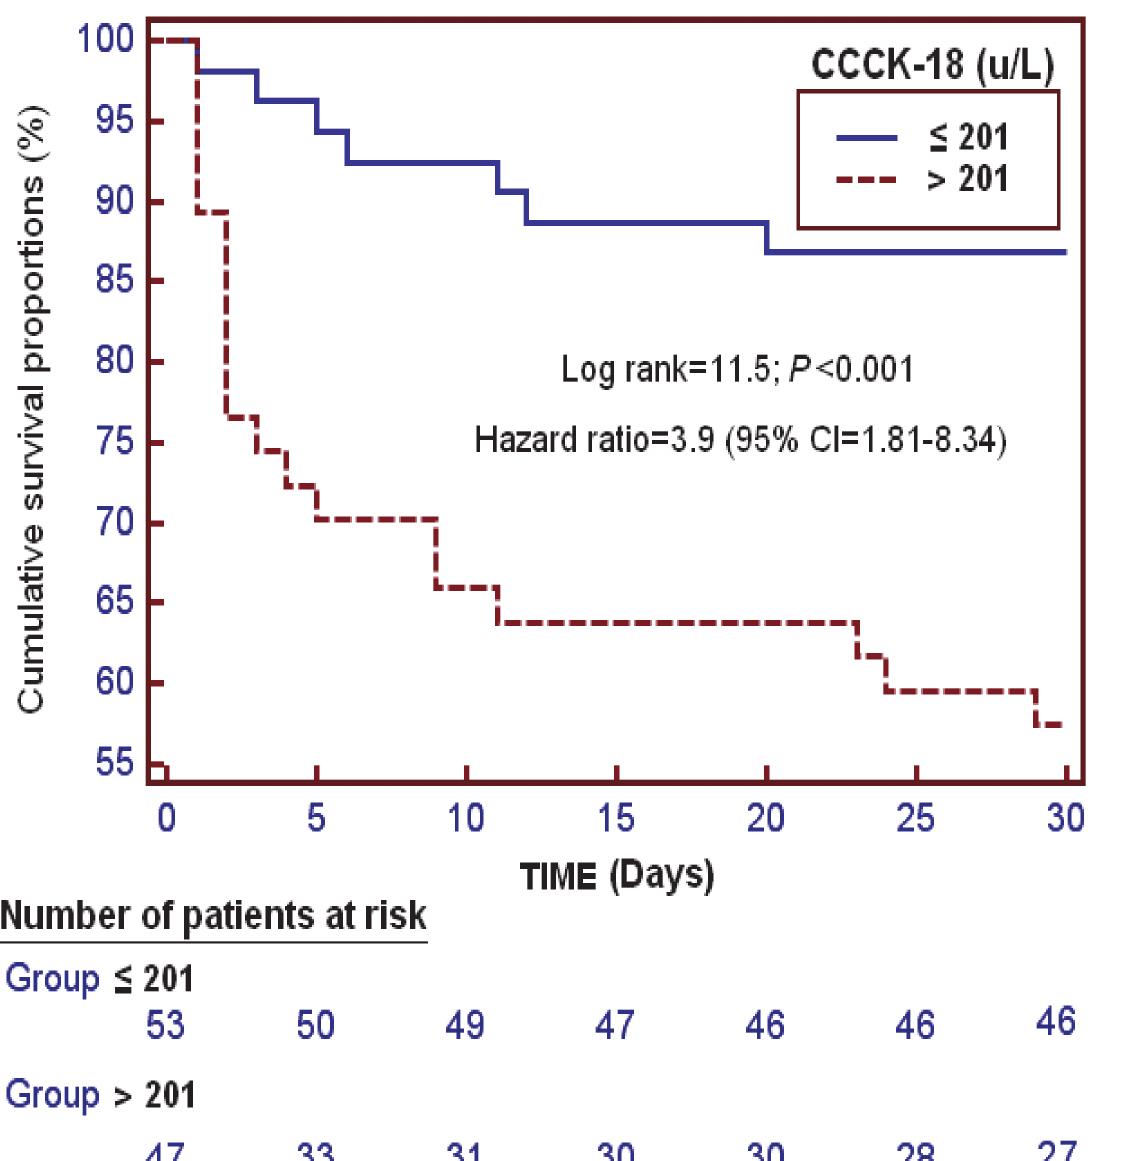
Fig 2. Survival curves at 30 days using serum caspase-cleaved cytokeratin (CCCK)-18 levels higher or lower than 201 u/L.